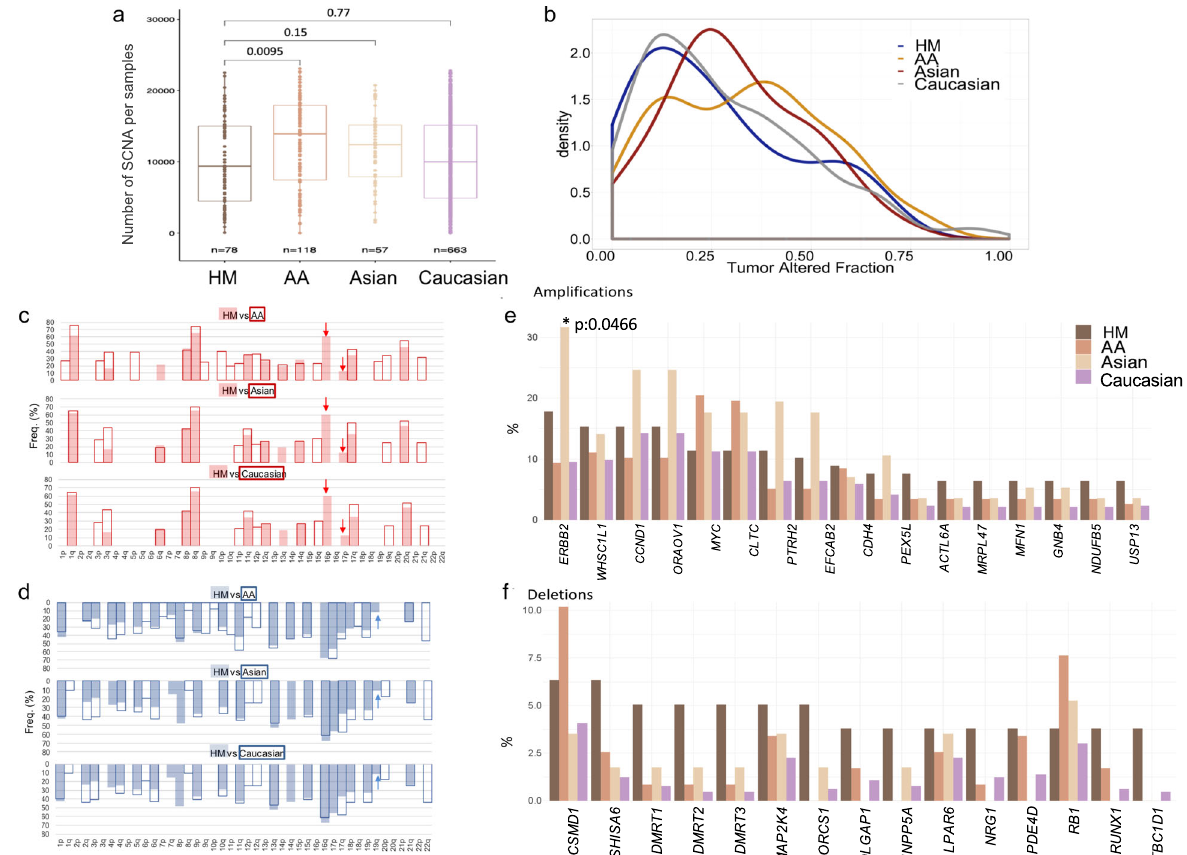
Fig. 6 SCNAs landscape in breast tumors across ancestries. a Boxplot shows the total number of SCNAs (including likely-signi fi cant (±1) or signi fi cant (±2) events) per sample among patients from HM ancestry and TCGA multi-ancestry data. SCNAs analysis was performed on SNP6 Affymetrix arrays data. Statistical comparisons based on two-tailed Wilcoxon test taking HM dataset as reference. Boxplots represent median ± IQR (25th and 75th percentile) and whiskers correspond to maximum and minimum values. b Histogram showing the comparative tumor SCNA burden (TSCB) distribution between ancestries. c , d Histogram showing the frequency of signi fi cant SCNAs at arm level across whole genome in different ancestries. Chromosomic regions are arranged on the x -axis. Gains are represented in red, above horizontal line ( c ), while losses are represented in blue, under horizontal line d ). The comparison of HM ( fi lled bars) and AA, Asian and Caucasian (lines bars) was calculated and plotted separately. Arrows indicate unique HM SCNA arm events. Frequency of the top most signi fi cant e ampli fi cations and f deletions in HM patients, compared against their frequency in other ancestries. Two- sided Fisher ’ s exact test p -values with BH FDR correction were computed for statistical comparisons *(BH-adjusted p -value < 0.05). HM: